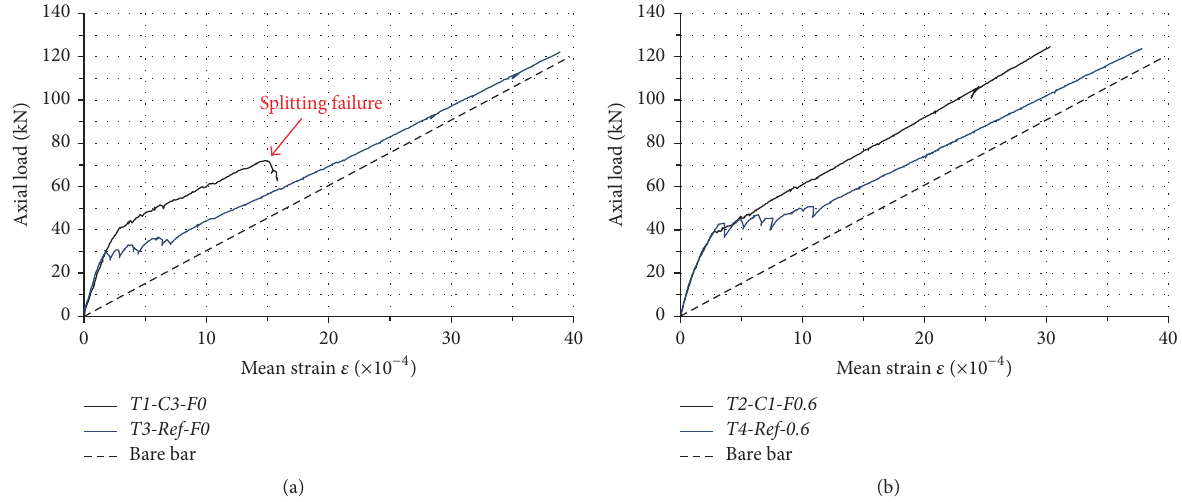
Figure 5: Load-strain diagrams of RC ties made of ordinary concrete (a) and SFRC (b).